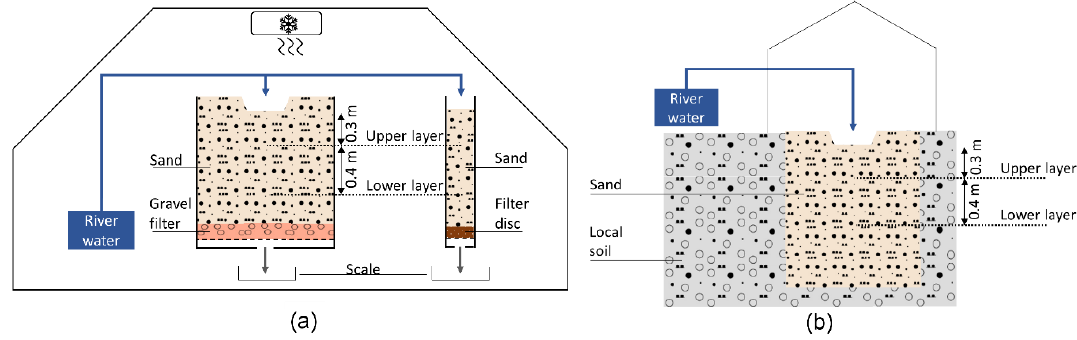
Figure 1. Cross sections of ( a ) laboratory scale unit tank and column and ( b ) field unit.